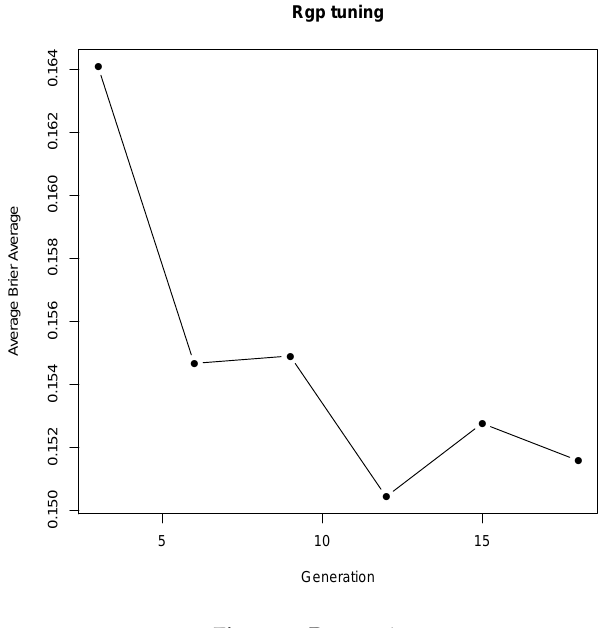
Figure 8. Rgp tuning.